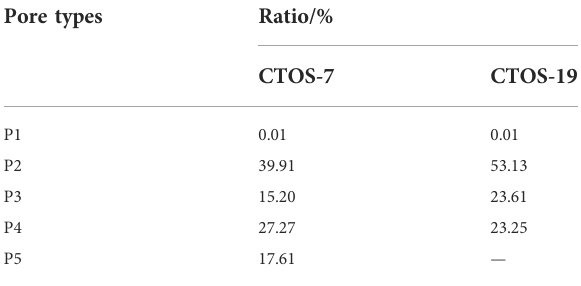
TABLE 2 The ratio of various types of pore in CTOS-7 and CTOS-19 samples. Pore